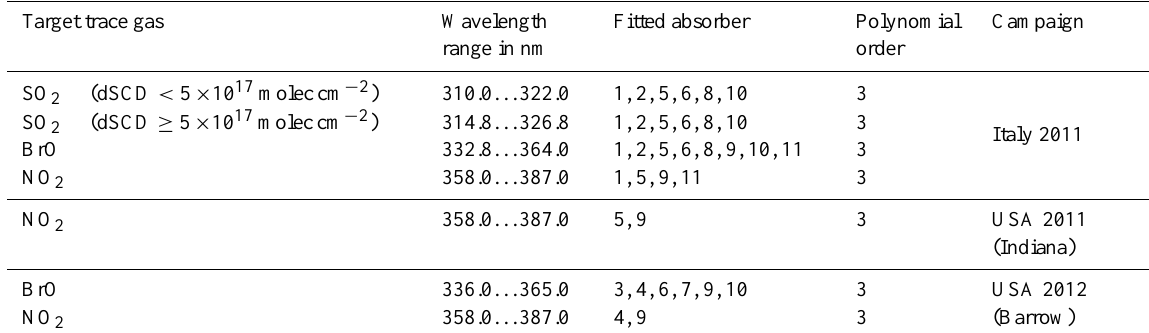
Table 6. List of fitted absorbers and selected wavelength intervals. In Italy two different fit ranges for SO 2 were applied, due to non-linearity at high optical densities (Kern et al., 2010; Bobrowski et al., 2010).